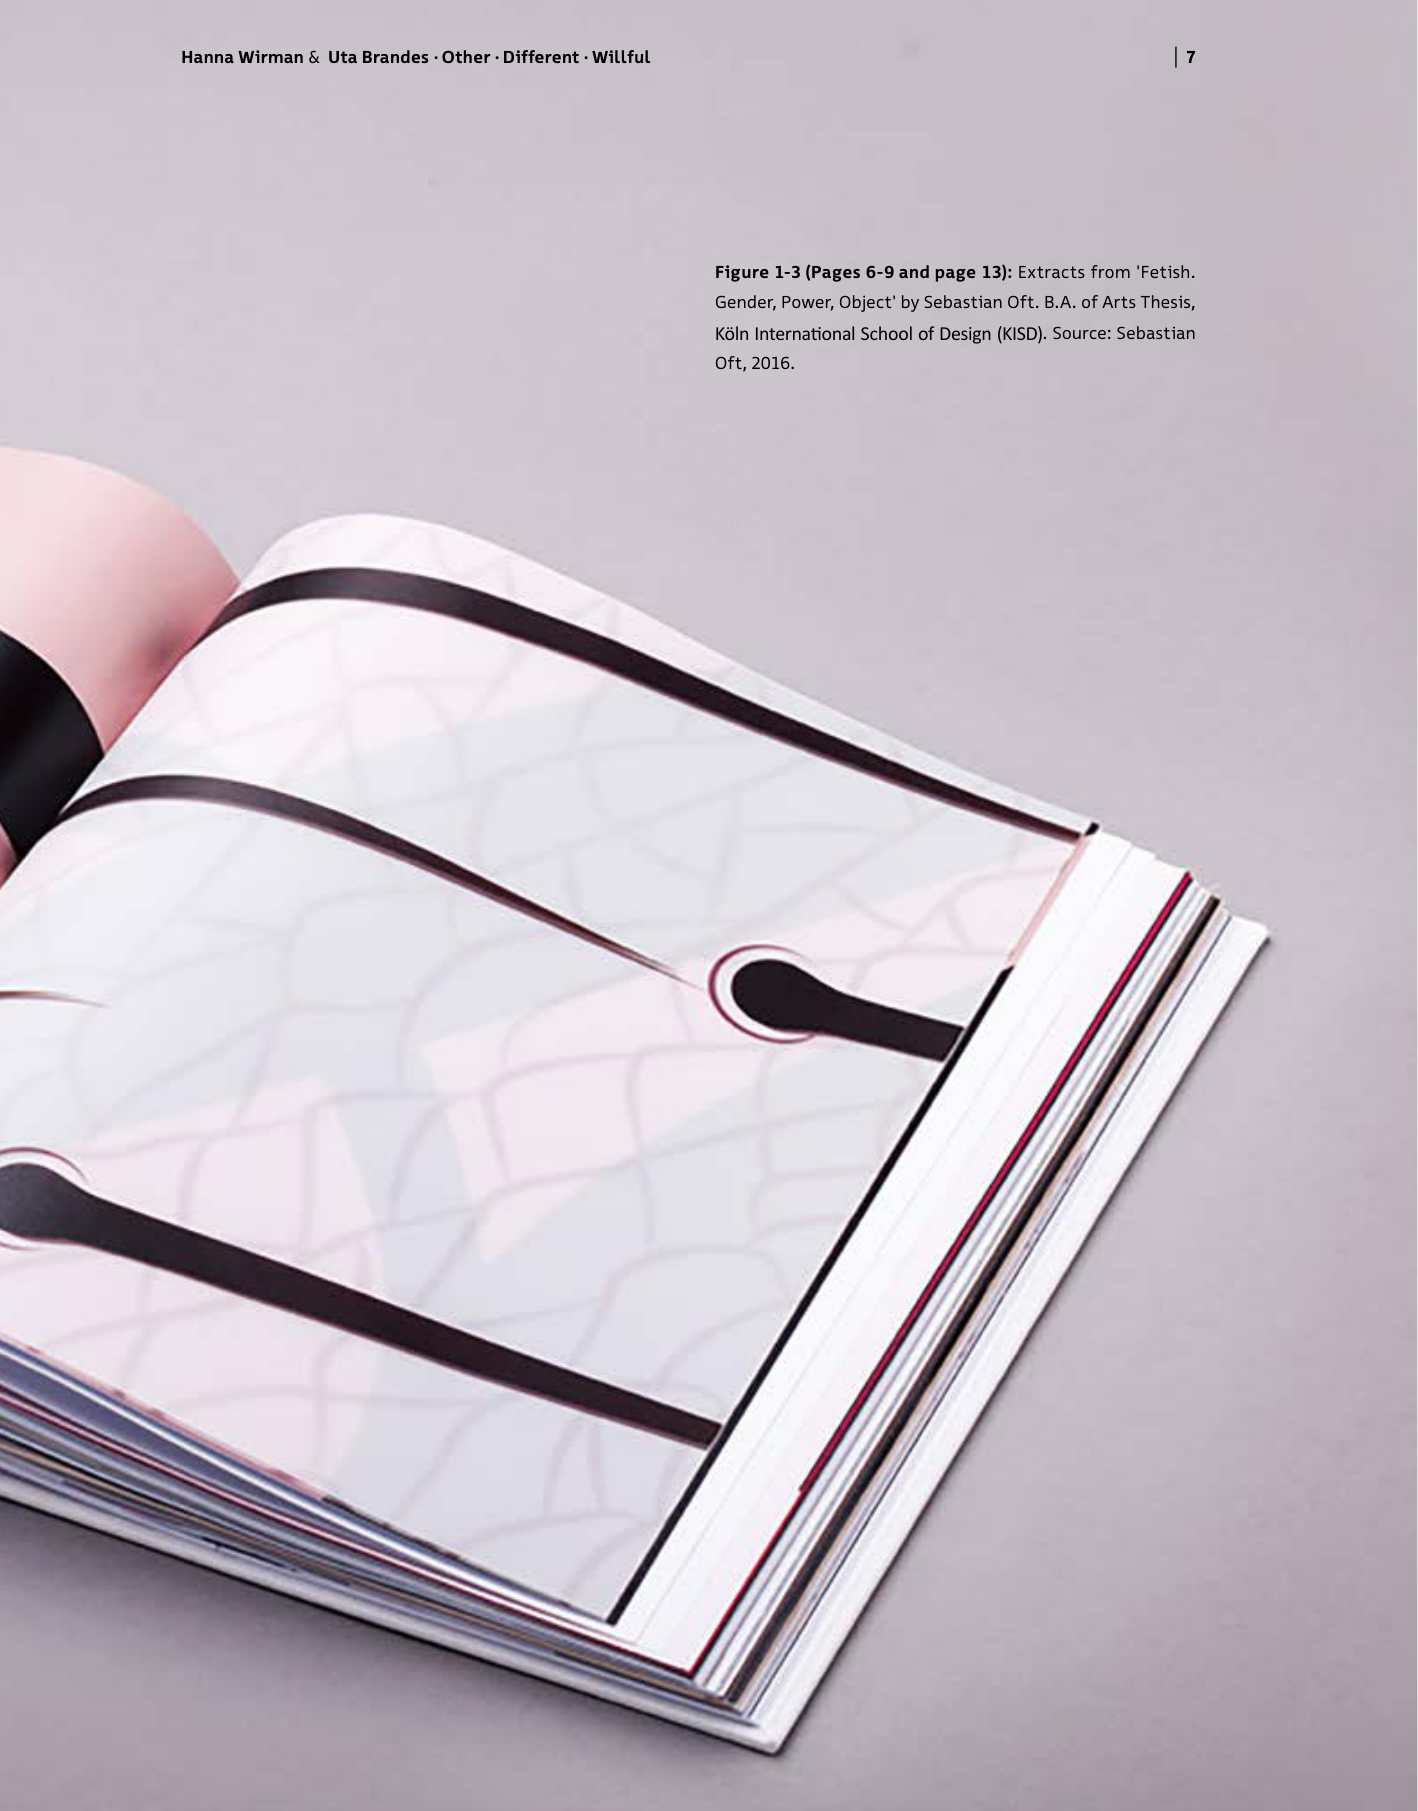
Figure 1-3 (Pages 6-9 and page 13): Extracts from 'Fetish. Gender, Power, Object' by Sebastian Oft. B.A. of Arts Thesis, Köln International School of Design (KISD) . Source: Sebastian Oft,